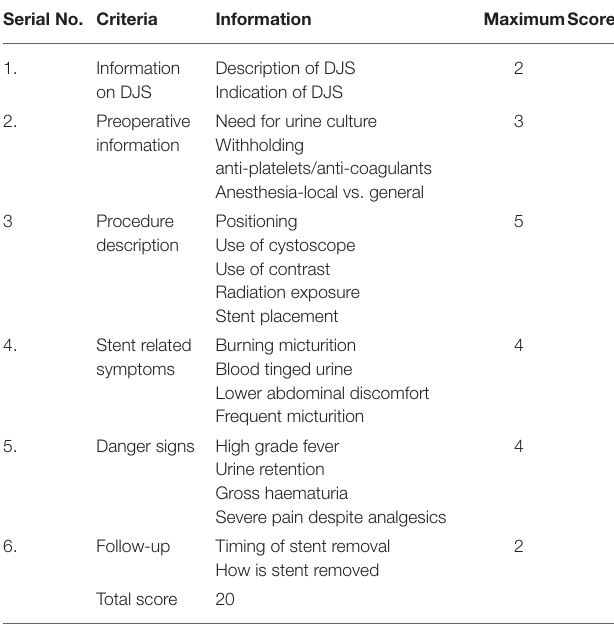
TABLE 1 | Scoring criteria for videos, based on European Association of Urology patient information sheet (1 point for each criteria). Serial No. Criteria